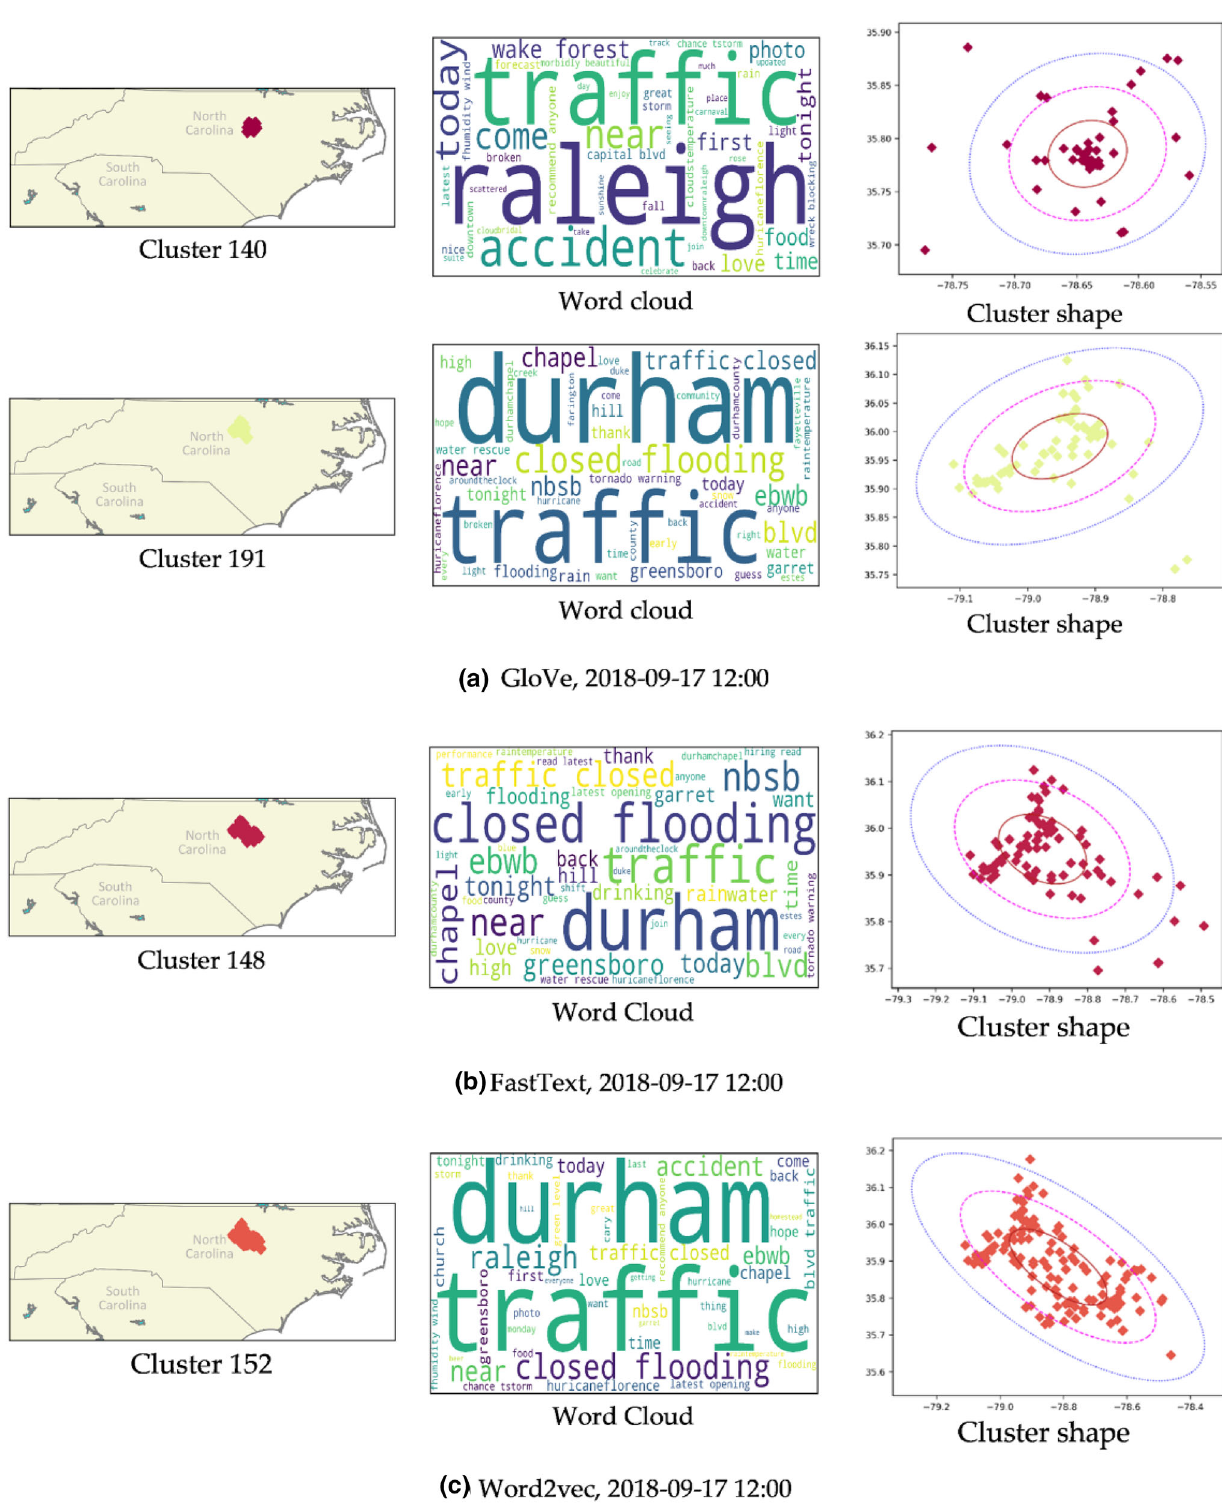
Fig. 6 An example of two tweet clusters extracted by a GloVe, compared to one cluster by b FastText and c Word2vec related to Hurricane Florence in North and South